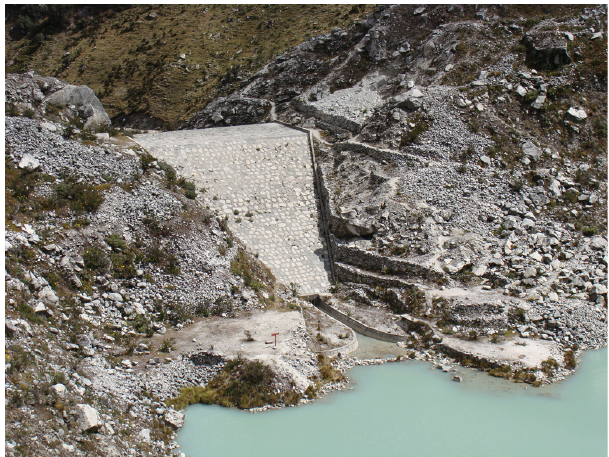
Fig. 6. Lake Palcacocha and its steep lateral moraines, which are predisposed to slope movements, in July 2012. The inset shows the two artificial dams (highlighted in orange) and siphons (black pipes within the lake) constructed during autumn 2011; the dam freeboard is about